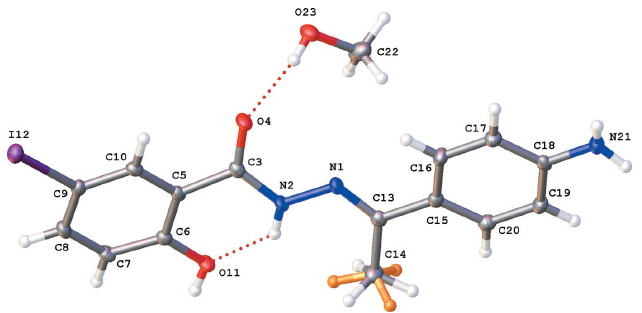
Figure 1 View of the asymmetric unit of the title compound, showing the atom- labelling scheme. Displacement ellipsoids are drawn at the 50% probability level. H atoms are shown as small circles of arbitrary radii. Intra- and intermolecular hydrogen bonds are shown as dashed